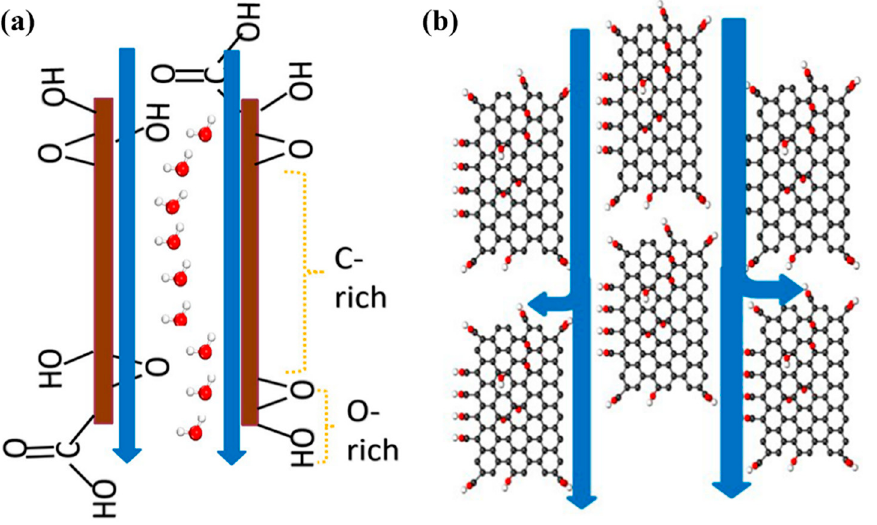
Figure 8. Water transport mechanism of water channels. ( a ) Single channel, ( b ) multilayer channels.